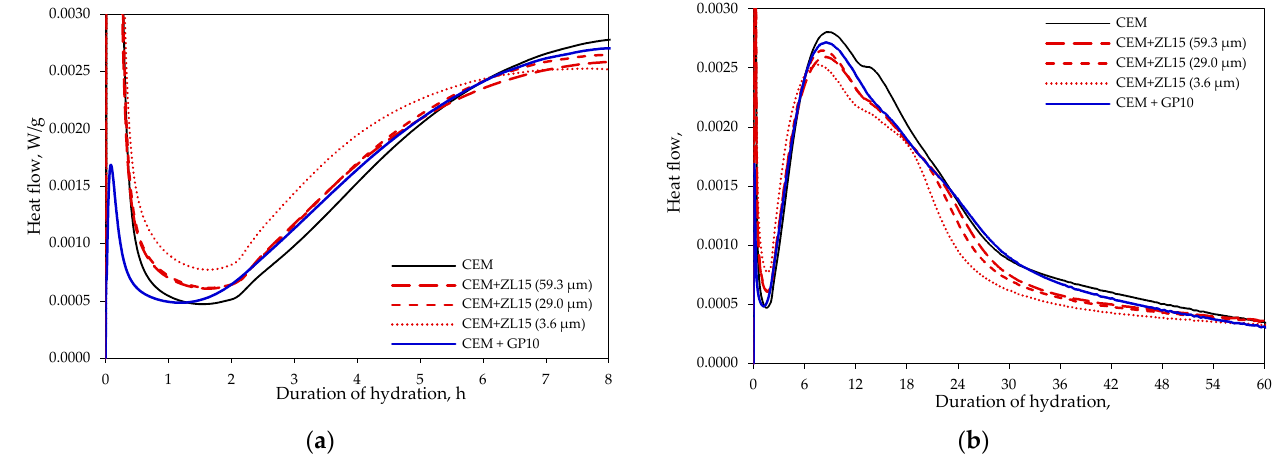
Figure 4. The dynamics of heat release: ( a ) 8 h of hydration; ( b ) 60 h of hydration.